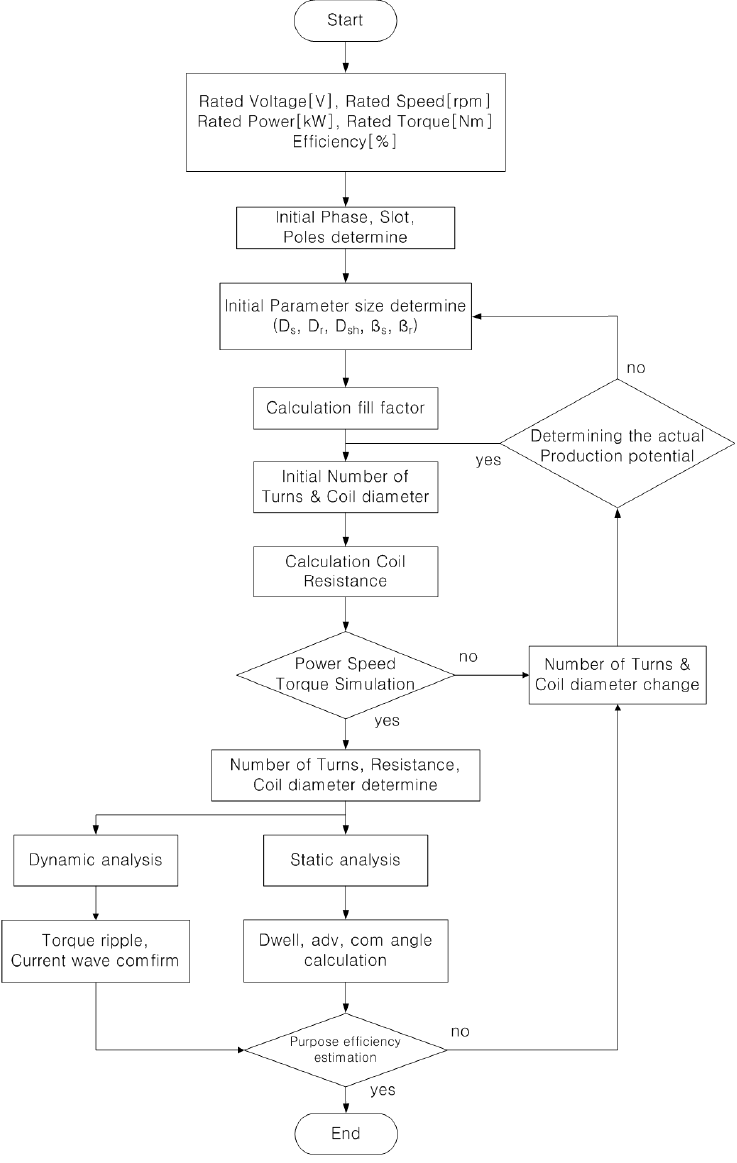
Figure 2. SRM design flowchart.